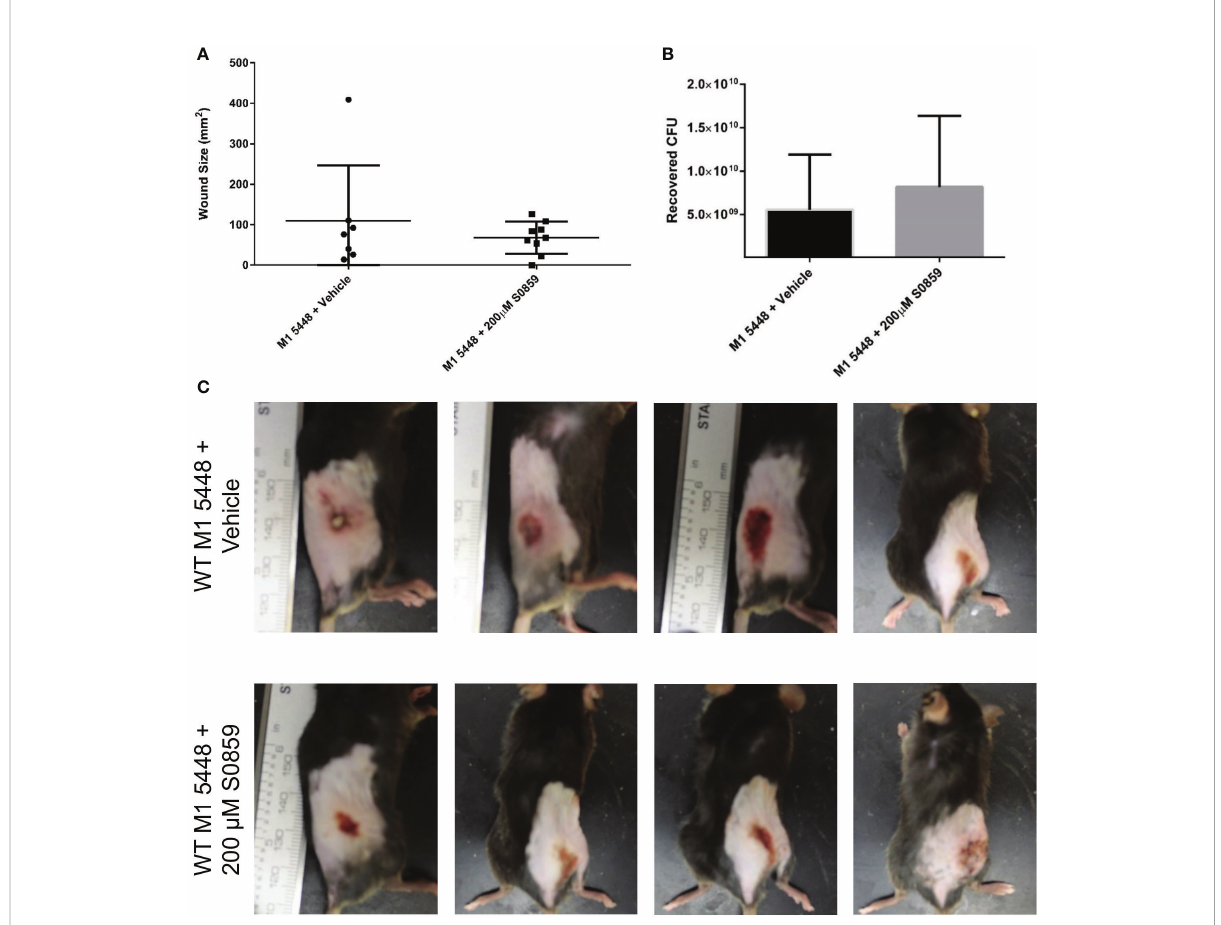
FIGURE 4 Multiple 200 µM S0859 treatments do not affect wound size in an in vivo model of GAS infection. C57BL/6 mice expressing the human plasminogen transgene were injected subcutaneously with wild-type M1 5448 GAS along with 0.7% saline (vehicle) or 200 µM S0859. Additional doses of saline or 200 µM S0859 were administered at 4 and 8 hours post-infection. After 24 hours, skin lesions were measured and imaged, and mice were sacri fi ced. Wounds were then excised and homogenized to determine GAS CFU. (A) Wound size in mm 2 following a 24 hour infection. (B) Recovered CFU from the infected wounds after 24 hours. (C) Representative images of wounds from each group following the